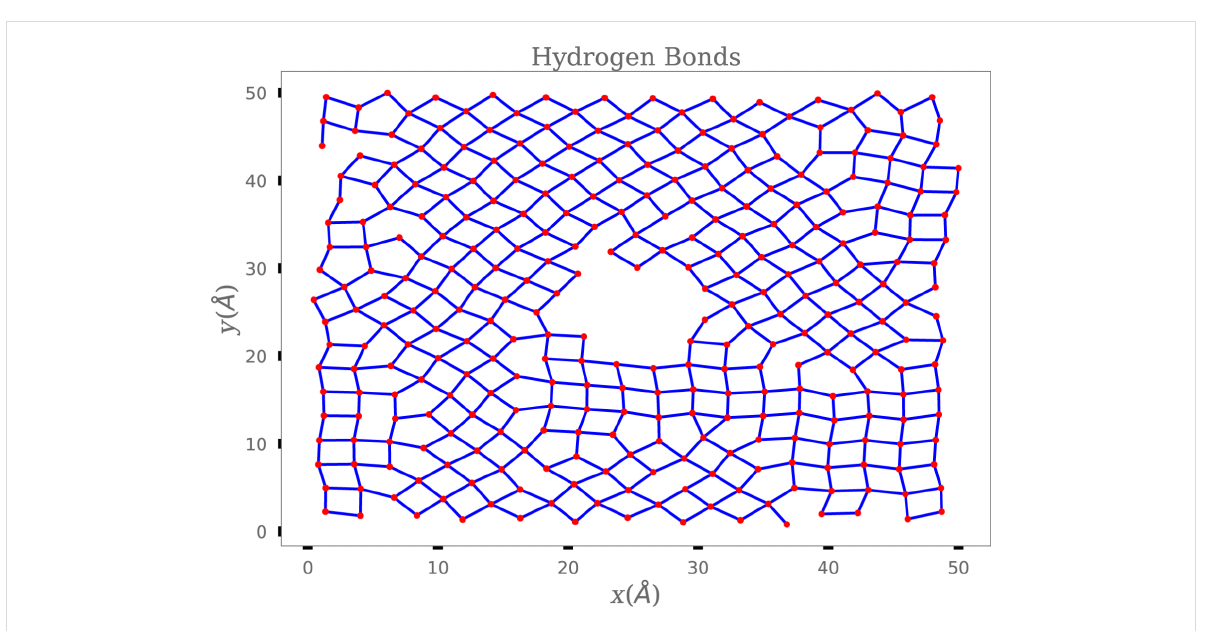
Figure 7: A snapshot of water molecules (red dots) on the attractive slab and hydrogen bonds (blue lines) at t = 0.5 ns. The central region is where the nanocone is placed; we did not plot the molecules for this region. The hydrogen bonds were calculated using the distances and angles between water